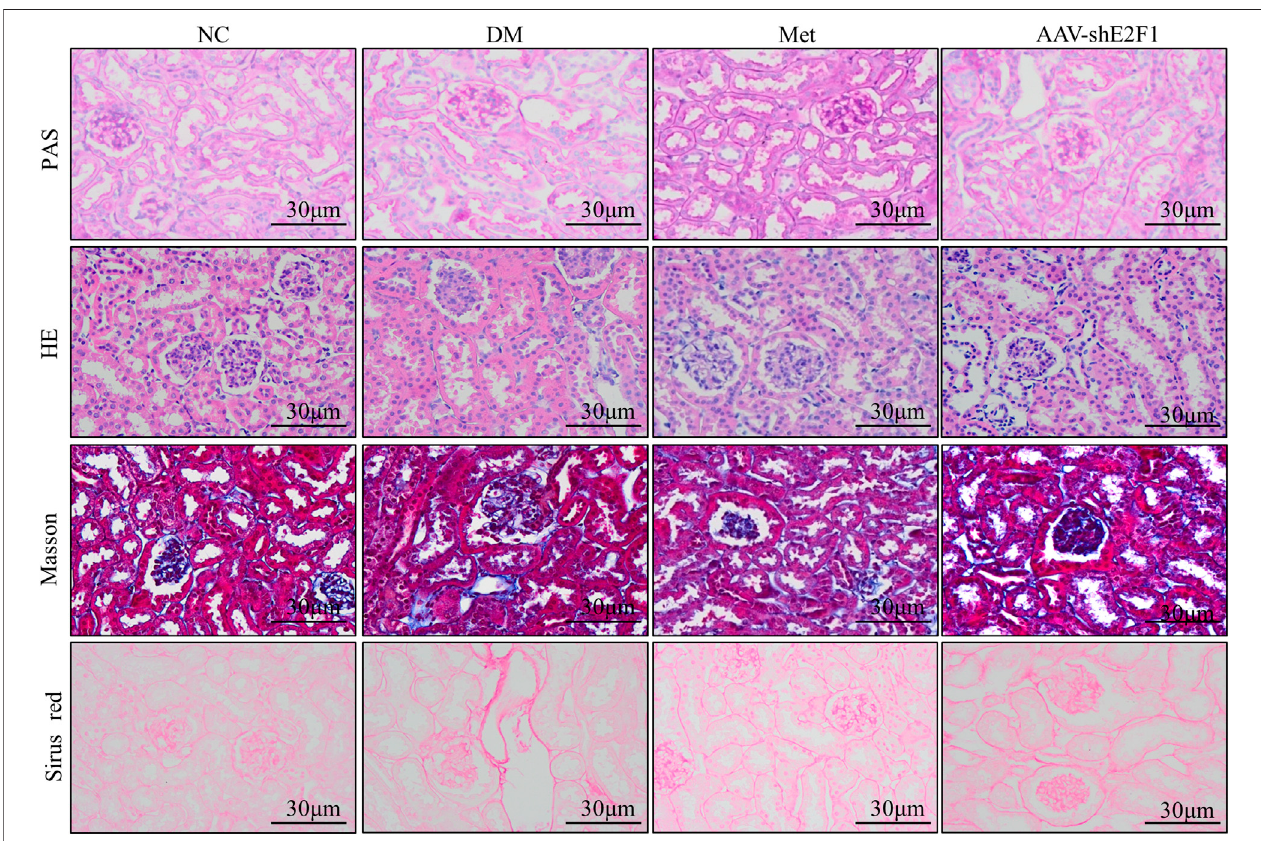
FIGURE 2 | Renal histopathological changes of mice in each group (PAS, HE, Masson, and Sirus red staining).